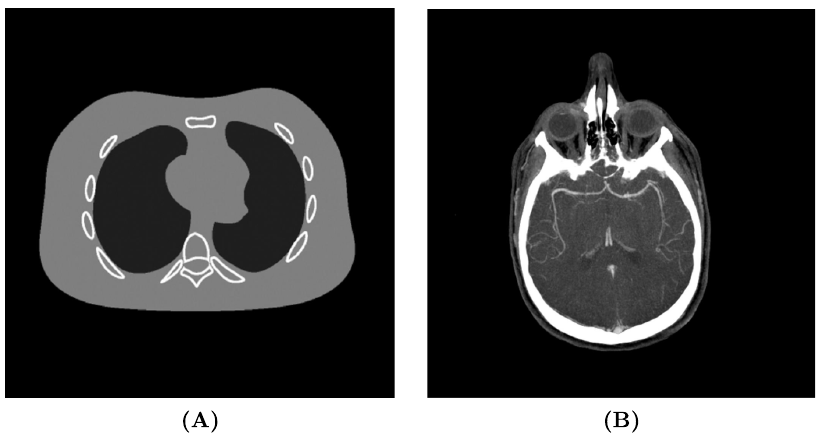
Fig 4. The two test images used in this paper. (A) NCAT phantom [34] with simple features; (B) real CT image with complex features. Both images are 2048 × 2048 pixels and normalized to a display window [0, 1].